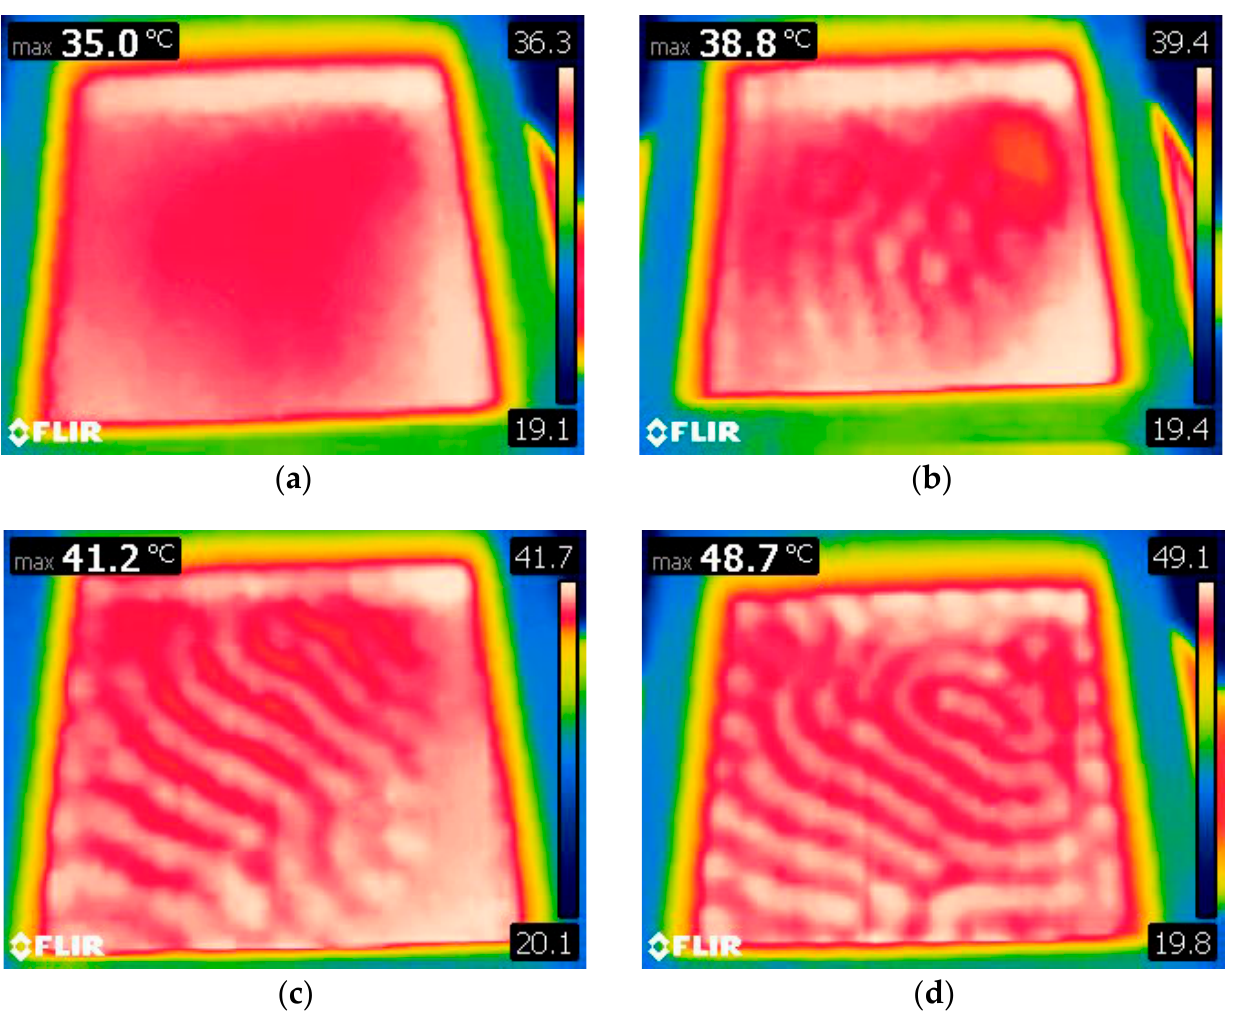
Figure 4. Surface temperature distribution for d = 0.50 cm ( Ω = 32 mL) and no inclination ( A = 16, Bo dyn ≅ 0.86, Ra ≅ 2.5 × 10 2 × ∆ T , Ma ≅ 2.94 × 10 2 × ∆ T ): ( a ) ∆ T = 13 °C, ( b ) ∆ T = 18 °C, ( c ) ∆ T = 21 °C, ( d ) ∆ T = 27 °C.